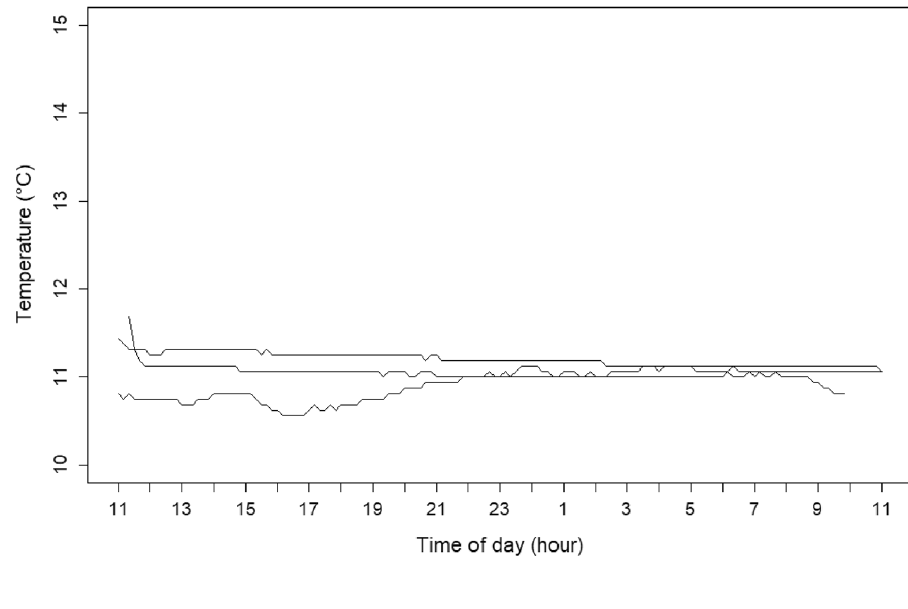
Fig. 9 Relative humidity data collected from within